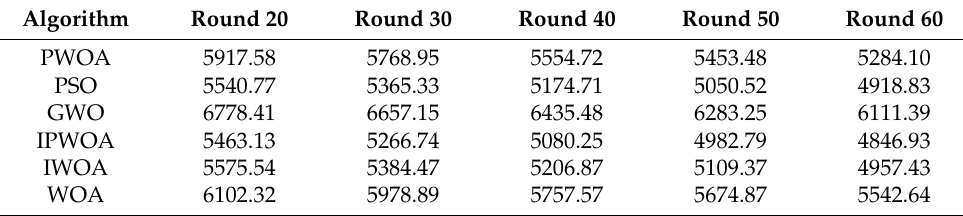
Figure 5. The optimization target value after multiple rounds of iterations of different algorithms. Each algorithm was executed for multiple rounds, each round of iterations included 200 times, and the average optimal optimization target value was generated. Table 2. Average optimization objective value after multiple iterations of different